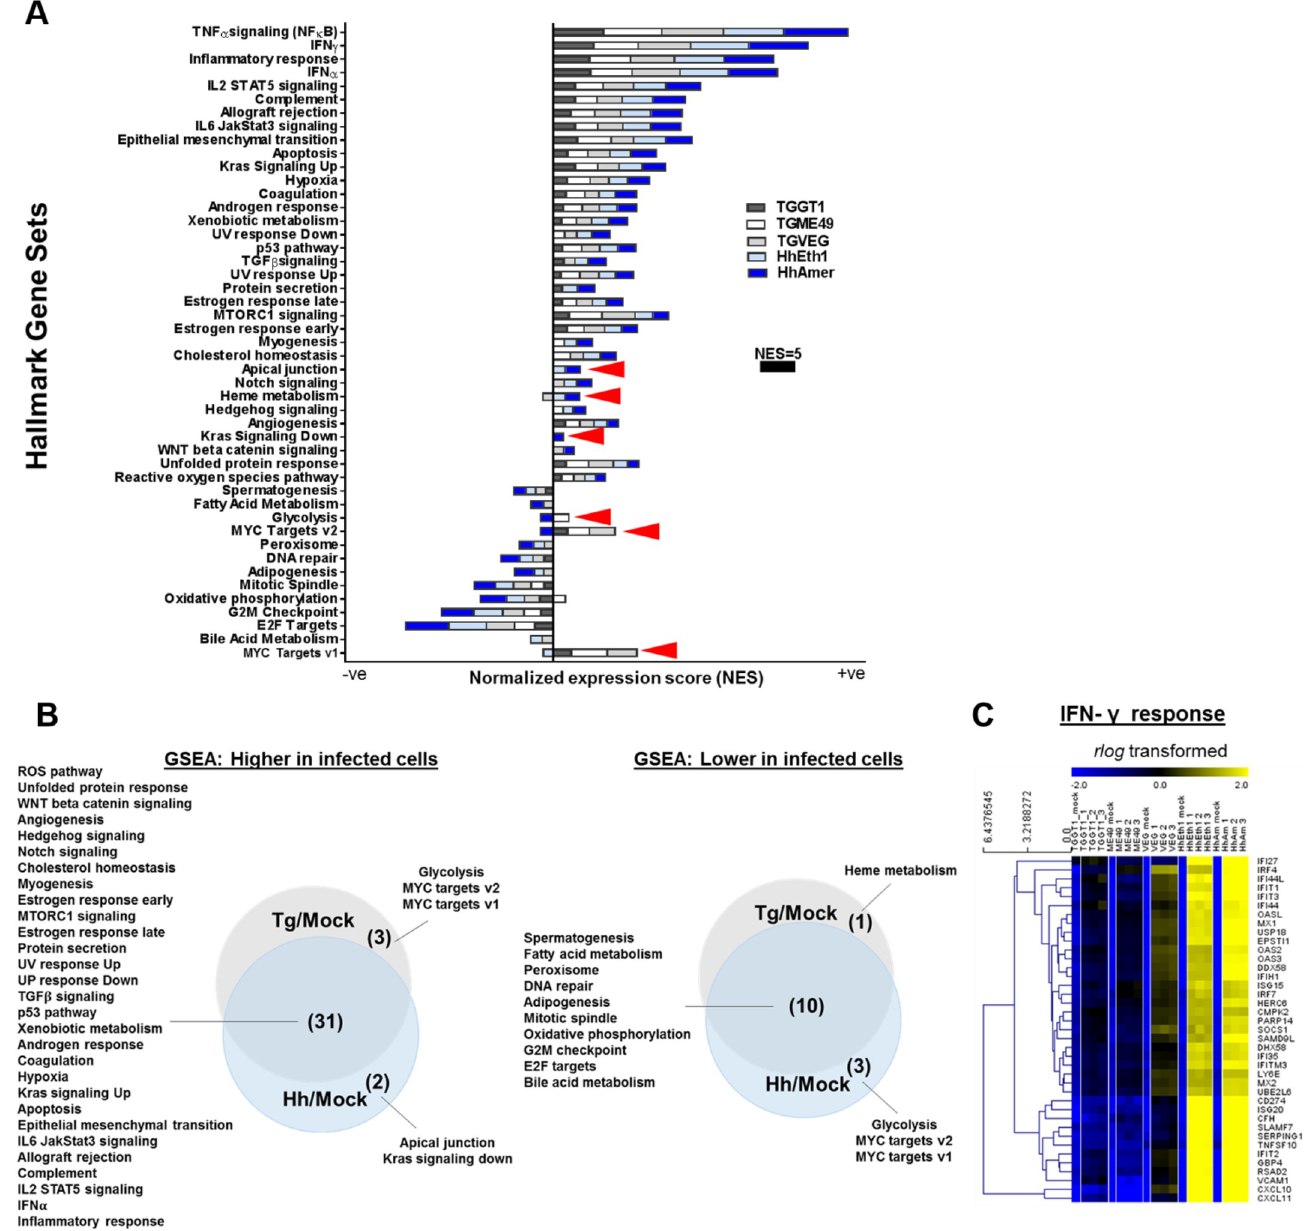
Fig 3. The majority of host pathways altered in T . gondii and H . hammondi -infected cells are shared between species. Normalized data was used to perform Gene Set Enrichment Analysis (GSEA) to understand biological relevance of the data set. (A) Bar graph shows normalized enrichment scores (NES) of positively (+ve) and negatively (-ve) enriched curated “Hallmark” gene sets in THP-1 cells in response to T . gondii (Tg; GT1, ME49 and VEG) and H . hammondi (Hh; Eth1 and Amer) infections as compared to mock-infected THP-1 cells. Shown are gene sets with a false discovery rate (FDR-q value) < 0.05 (computed with 1000 Monte- Carlo simulations). The NES represents the degree to which a gene set is overrepresented at the top or bottom of the ranked list. Bars show stacked NES scores by strain and species to permit comparison. Arrowheads indicate species-specific pathways. (B) Overlapping positive (left panel) and negative (right panel) gene set enrichments summarized in Venn diagrams. (C) Heatmap showing log 2 expression of a subset of genes from the IFN γ response gene set.